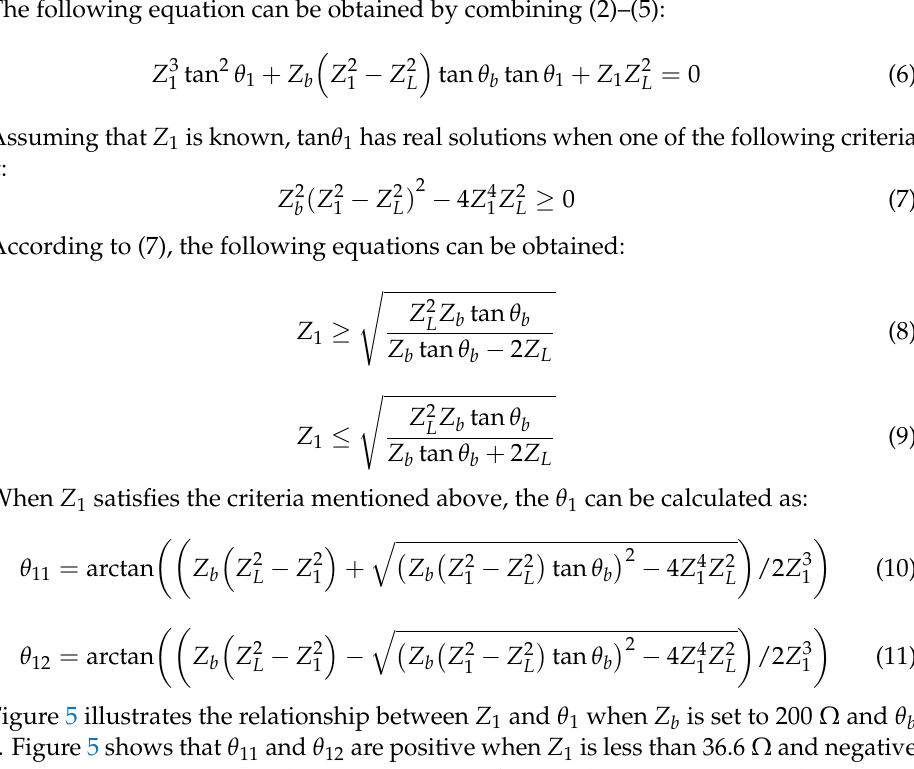
1 and θ 1 when Z b is set to 200